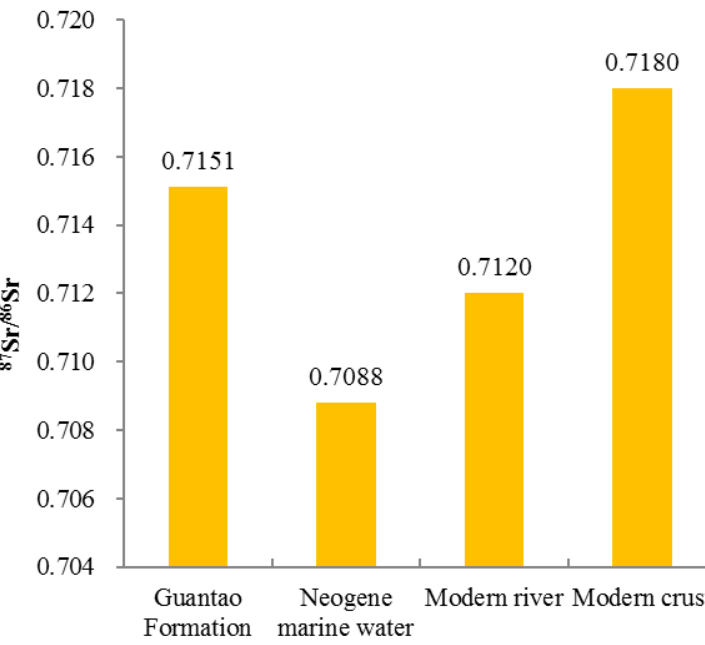
Figure 5. Comparison diagram of 87 Sr/ 86 Sr ratio of the Guantao Formation with Neogene marine water, modern river and modern crust [7].